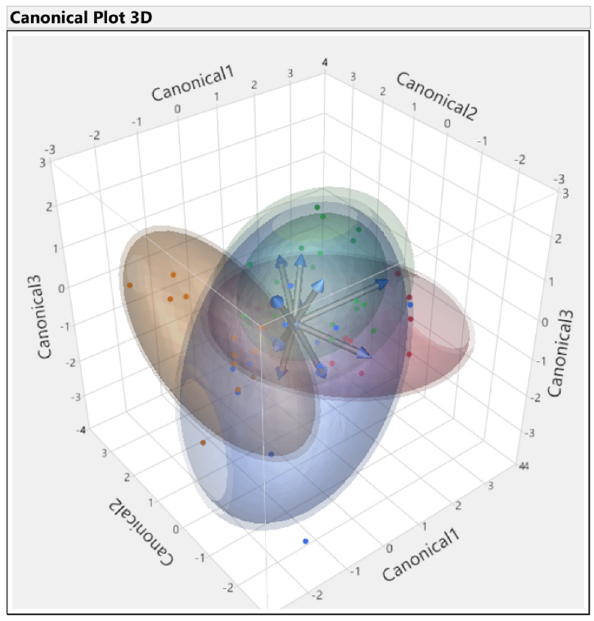
Figure 7. The 3D canonical plot of QDA results for discrimination of four groups based on the Combination 1 and 3 sets of characteristics, including the Shoot L, Shoot N, Leaf A, RWC, Chl a , EL, MDA, proline, CAT, and APX.